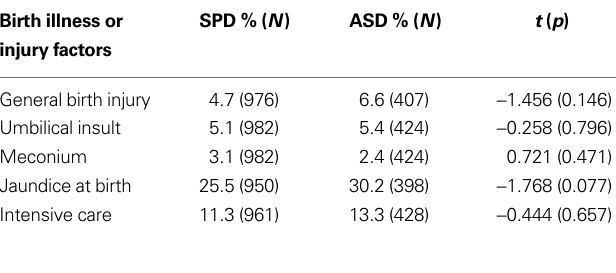
Table 5 | Percentage, valid N and T -test of birth-related injuries and illnesses factors.